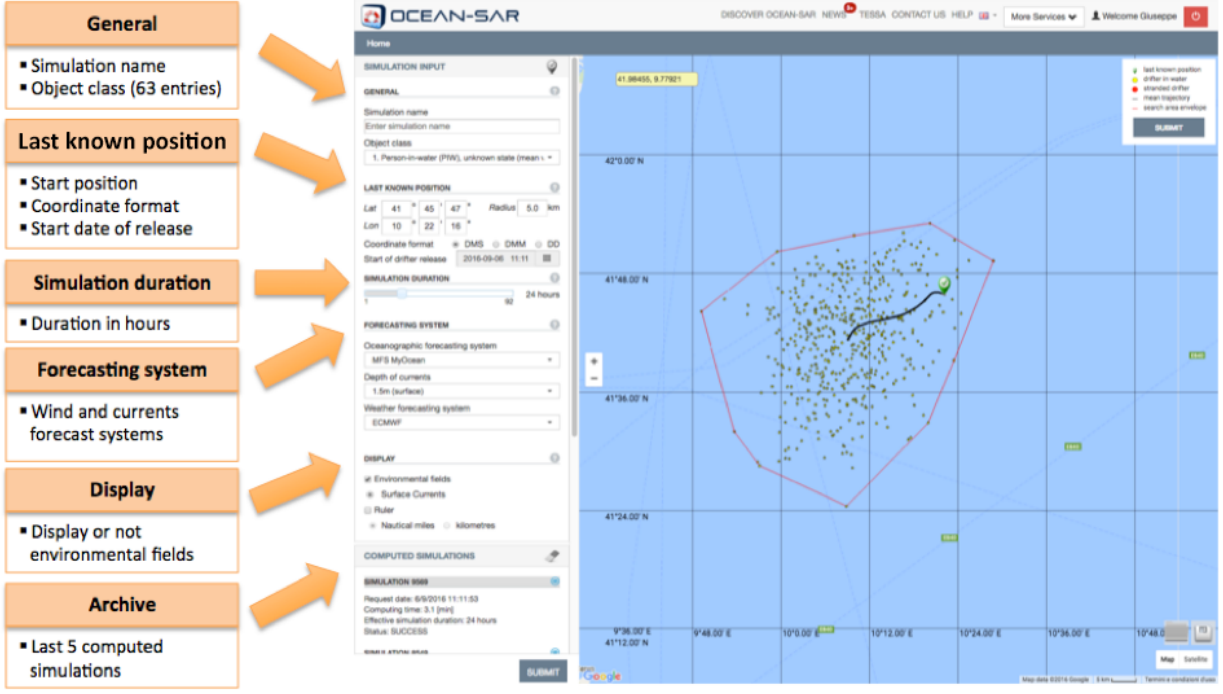
Figure 5. The parameters of simulation displayed on the UI are available on the left side of the UI. The boxes on the left side of the figure describe the different